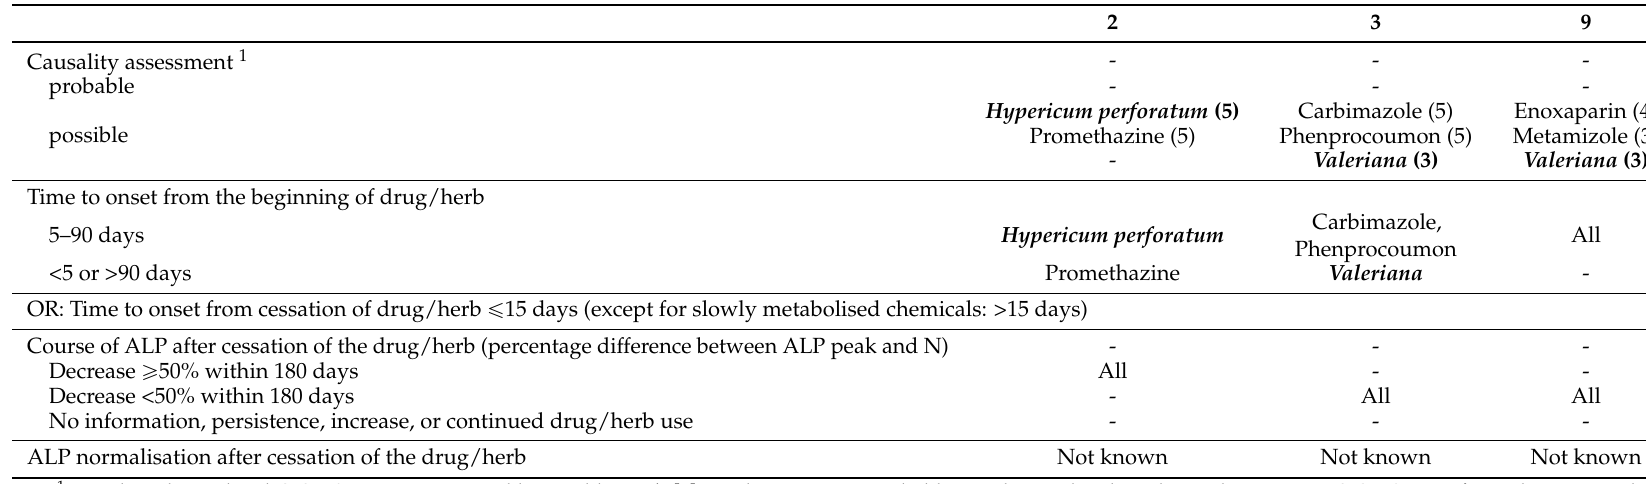
Table 4. Data on drug or herb intake of the patients with herbal-induced liver injury and cholestatic or mixed patterns.